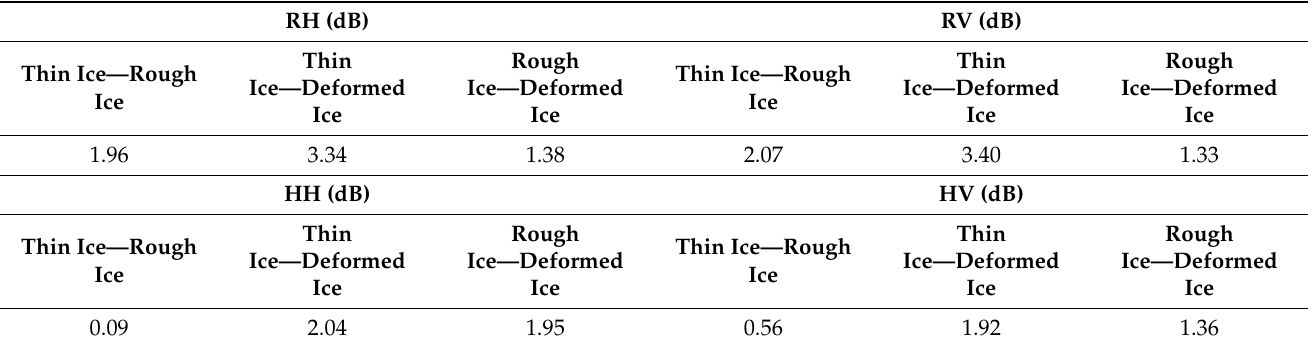
Table 5. Contrast of Sea Ice Types in RCM and RADARSAT-2 Images Expressed in Absolute Mean Backscattering